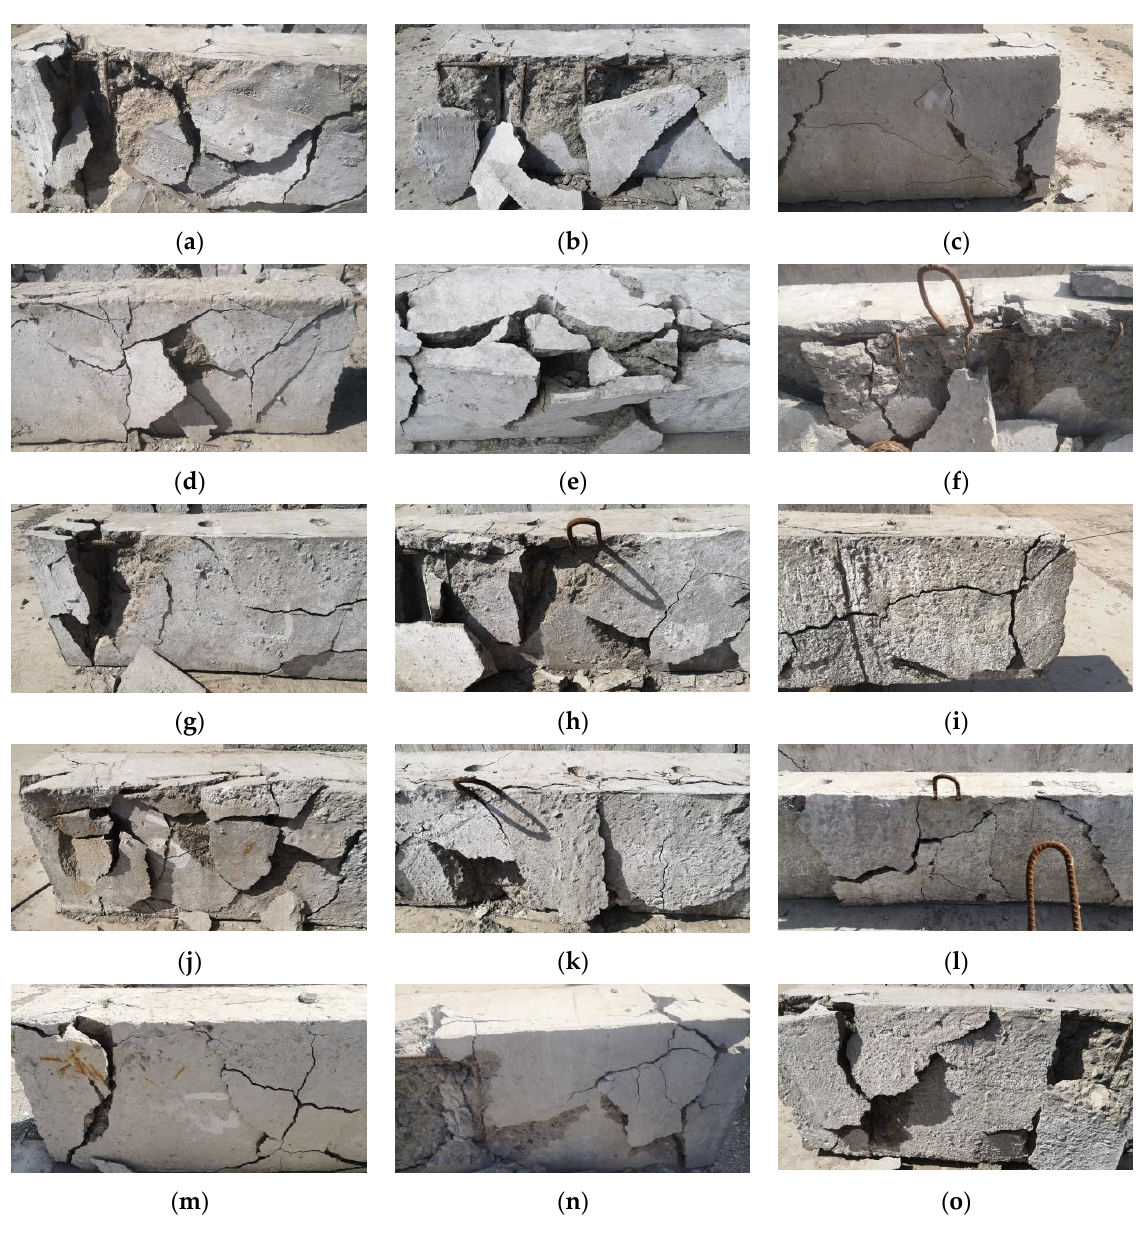
Figure 9. Breaking effect of Hole 1. ( a ) Beam L1; ( b ) Beam L2; ( c ) Beam L3; ( d ) Beam L4; ( e ) Beam L5; ( f ) Beam L6; ( g ) Beam L7; ( h ) Beam L8; ( i ) Beam L9; ( j ) Beam L10; ( k ) Beam L11; ( l ) Beam L12; ( m ) Beam L13; ( n ) Beam L14; ( o ) Beam L15.